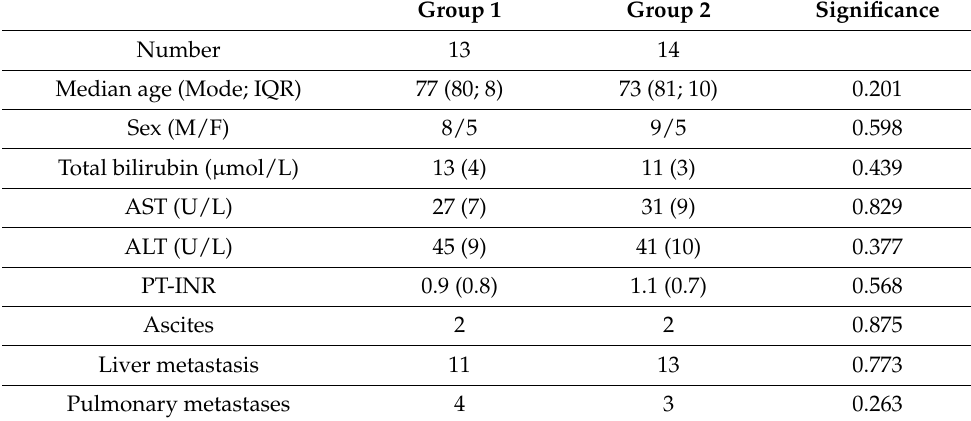
Table 1. Demographics and clinical